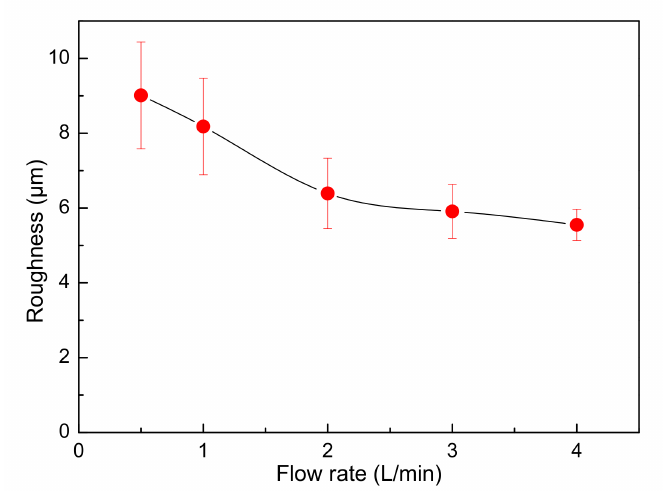
Figure 5. Effect of electrolyte circulation rate on the surface roughness of cathode copper in the conventional inlet mode. Bars represent standard deviation.